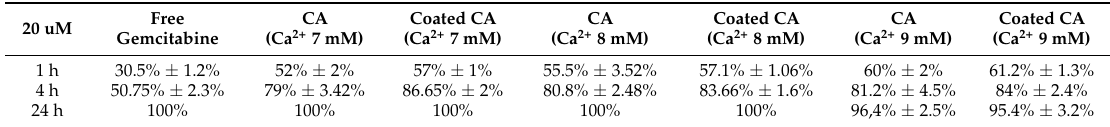
Table 8. Time-dependent cellular uptake of surface-modified and unmodified, gemcitabine-loaded CA particles in MCF7 cell line. CA was formed with different Ca 2+ concentrations (7, 8 and 9 mM) and 20 µ M of gemcitabine. Free gemcitabine (20 µ M) was used as